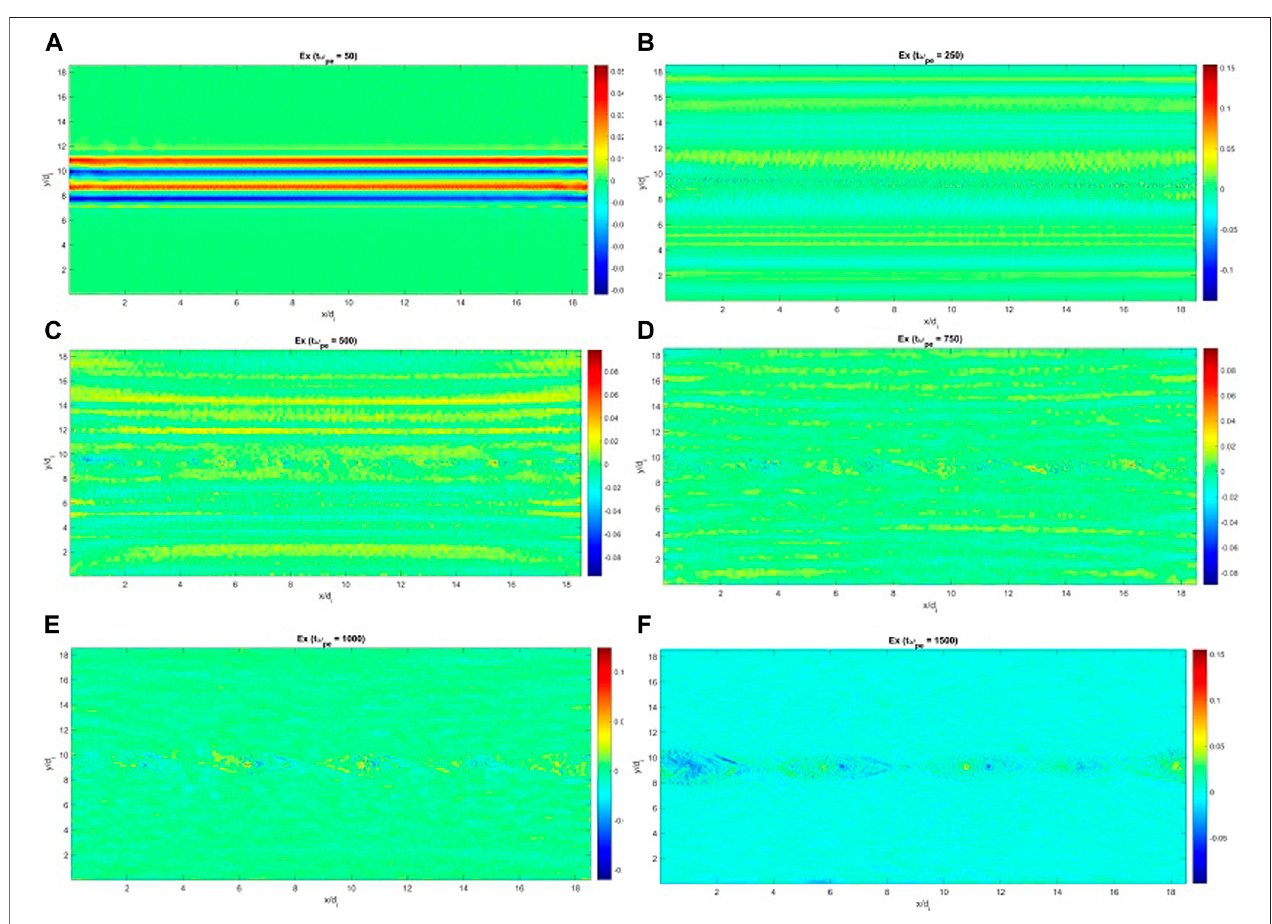
FIGURE 2 | E x component of the electric fi eld at times: t ω pe (cid:1) 50 (A) , 250 (B) , 500 (C) . 750 (D) , 1,000 (E) , 1,500 (F) with b z 0 (cid:1) 0.3 B 0 .